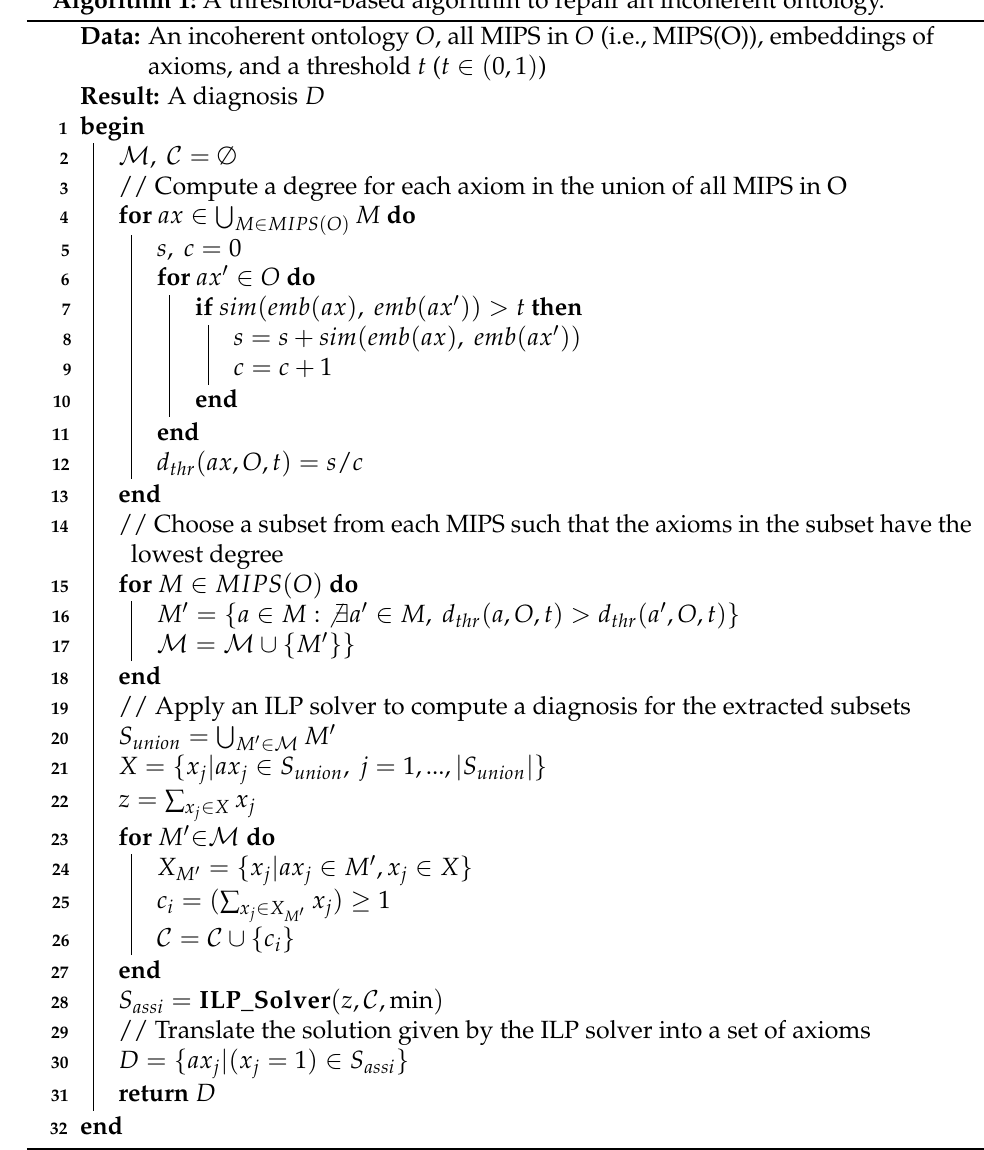
Algorithm 1: A threshold-based algorithm to repair an incoherent